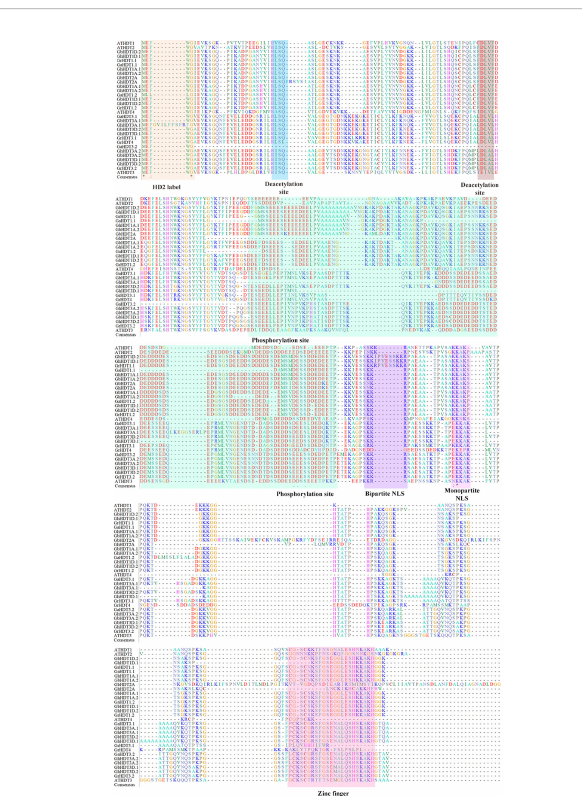
FIGURE 1 Results of multiple sequence alignment (MSA) of cotton HD2 proteins with Arabidopsis HD2s. MSA of 27 putative Gossypium HD2 proteins and four Arabidopsis HD2 proteins performed by Clustal X. Orange, blue, brown, violet, and pink- colored shading indicates the conserved sites (HD2 label, phosphorylation sites, bipartite NLS, monopartite NLS, and zinc fi nger, respectively) of a typical HD2 protein. Green, yellow, and blue letters with an asterisk represent amino acid conservation in all the domains.